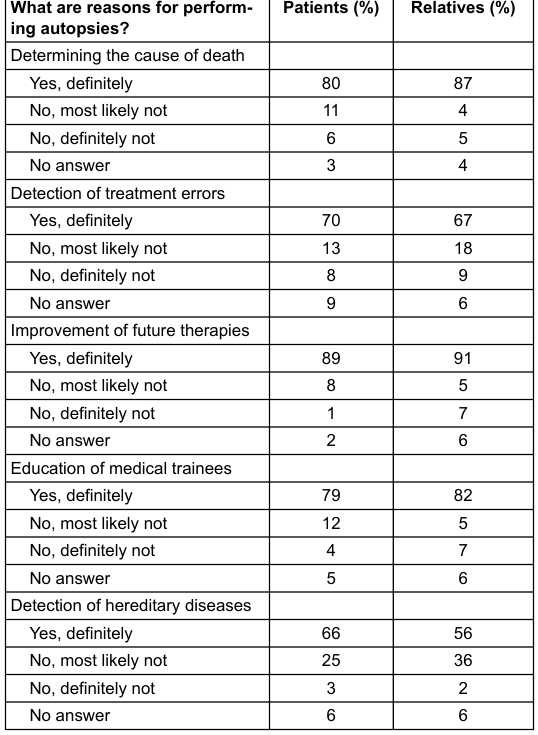
Table 2: Reasons for performing autopsies as seen by multimorbid pa- tients (n = 91) and their first-degree relatives (n = 55). What are reasons for perform- ing autopsies?